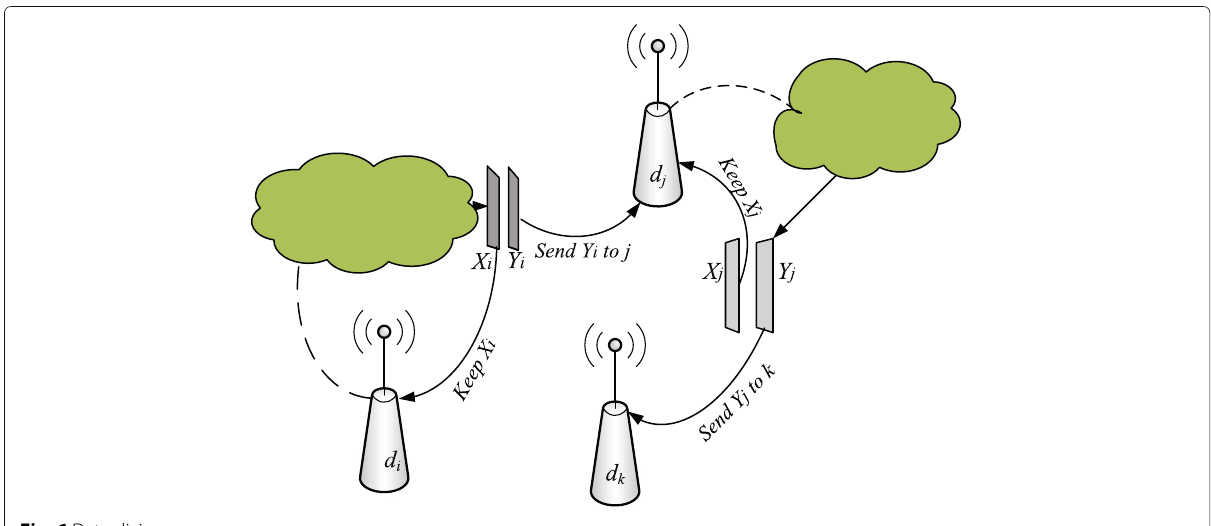
Fig. 6 Data slicing